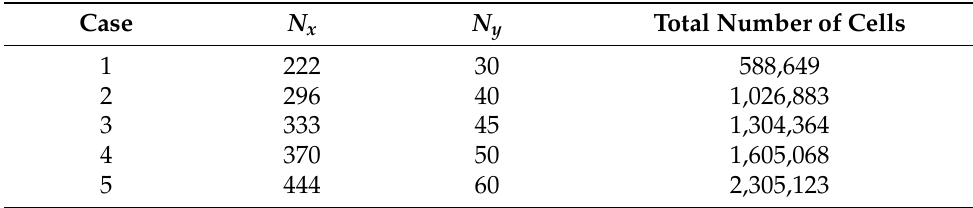
Table 2. Summary of the meshes used in the sensitivity analysis. N x and N y are the number of coarse cells in the streamwise and transverse